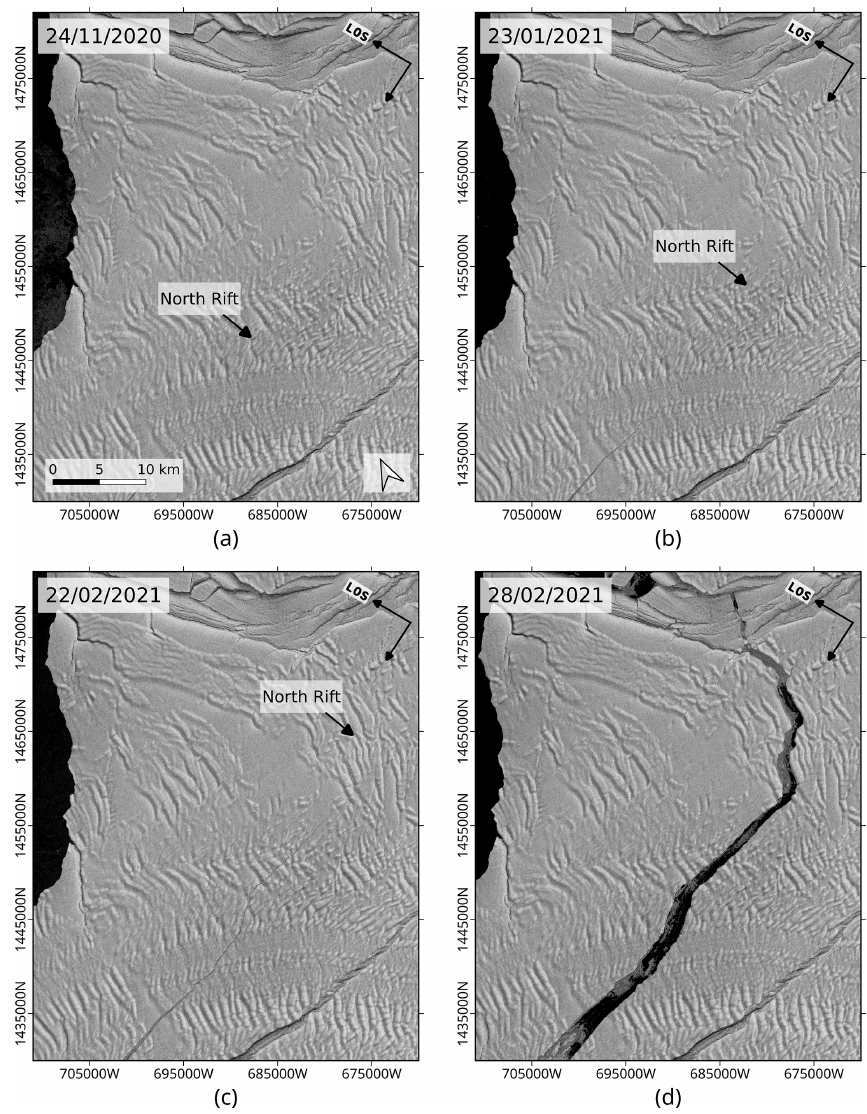
Figure 11. Propagation of the North Rift between the end of November and end of February observed with a series of Sentinel-1 radar brightness images. The iceberg A74 formed on 26 February 2021. The images focus on the same area as the interferograms in Fig. 6. (a) 24 November 2020. (b) 23 January 2021. (c) 22 February 2021. (d) 28 February